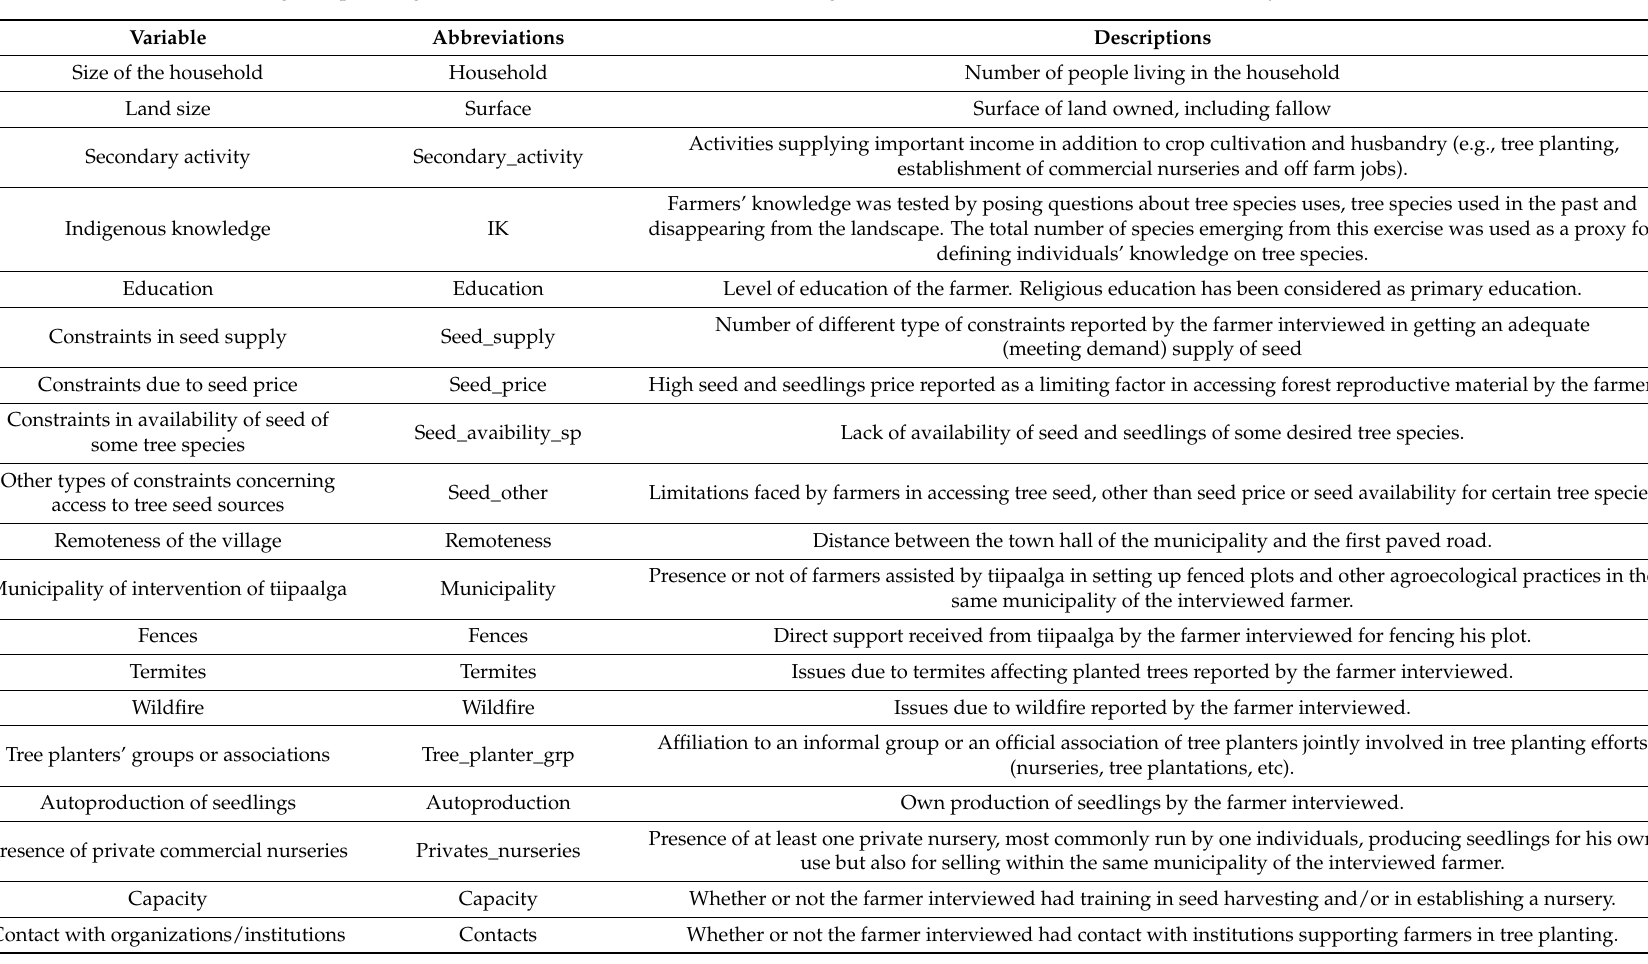
Table 1. List of the 19 variables structuring individual questionnaires, considered to have an influence in determining farmers’ choices regarding management of natural resources, including tree planting. The variables were used for constructing the four models in the Random Forest